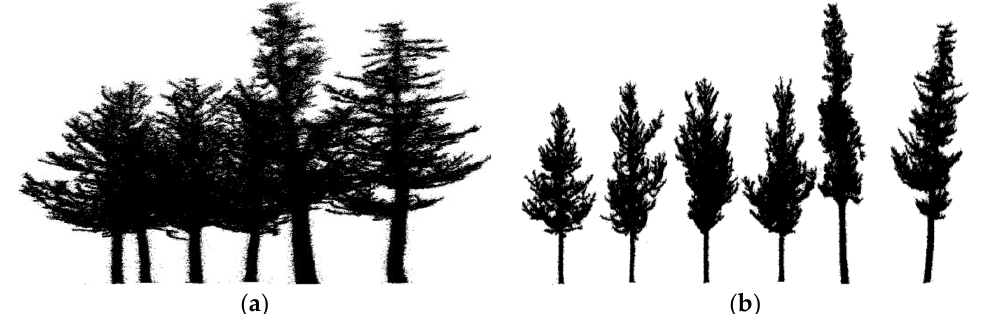
Figure 5. Pixel coincidence ( a ) and non-coincidence ( b ) projection map.